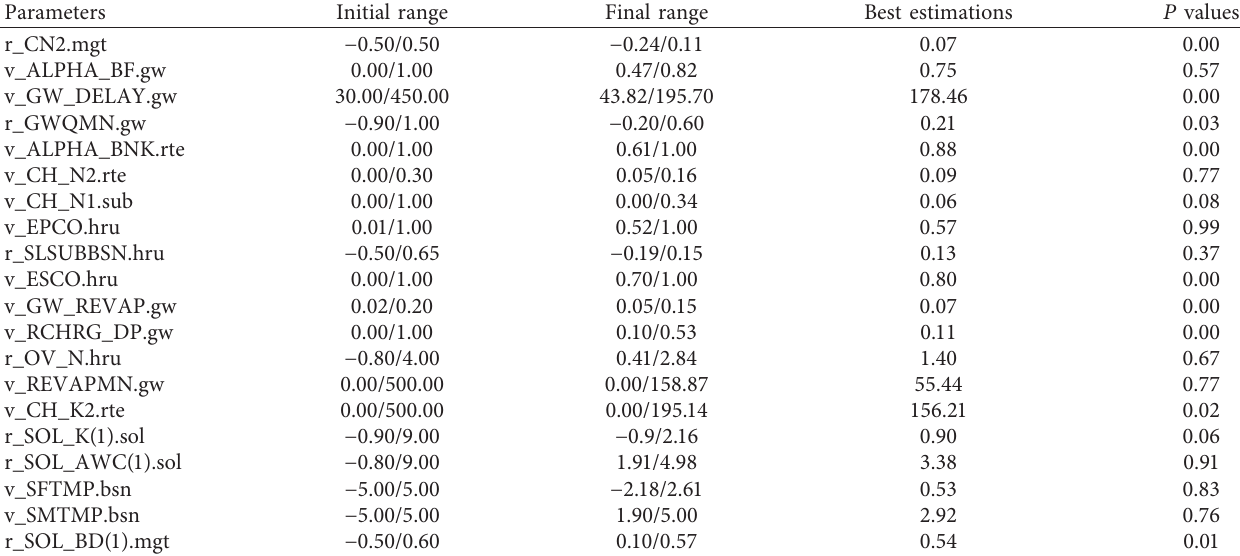
Table 5: Initial and final ranges, best estimations, and P values for SWAT calibration.